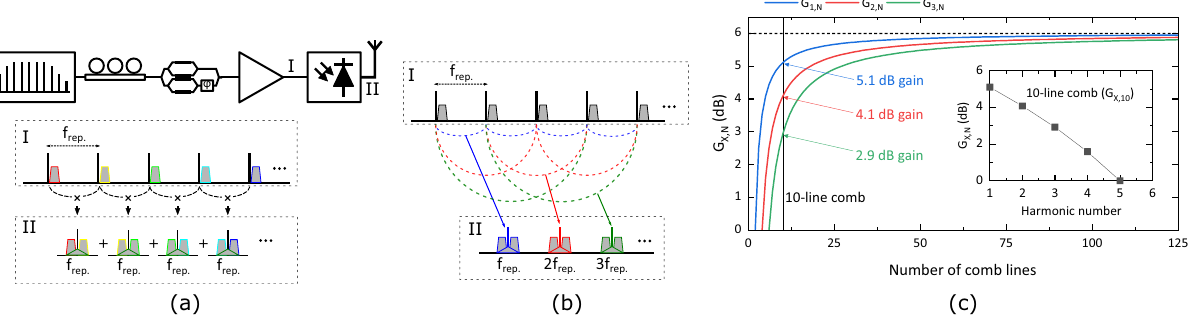
Figure 6. ( a ) Direct-comb-modulation THz transmitter and spectra of the signal before and after the PD, ( b ) signal multiplication in a comb-based THz transmitter, and ( c ) curves for G 1, N , G 2, N , and G 3, N (inset shows G X ,10